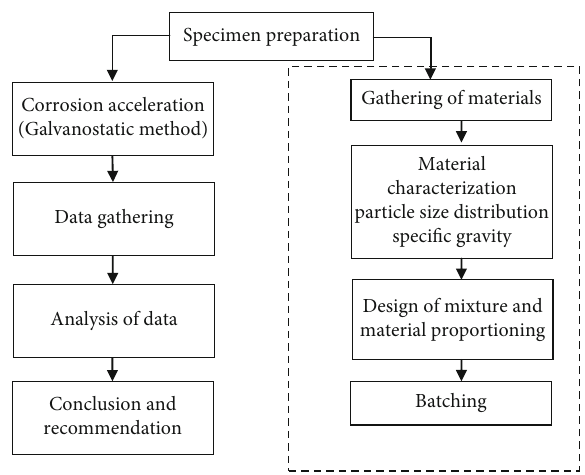
Figure 1: Research fl ow